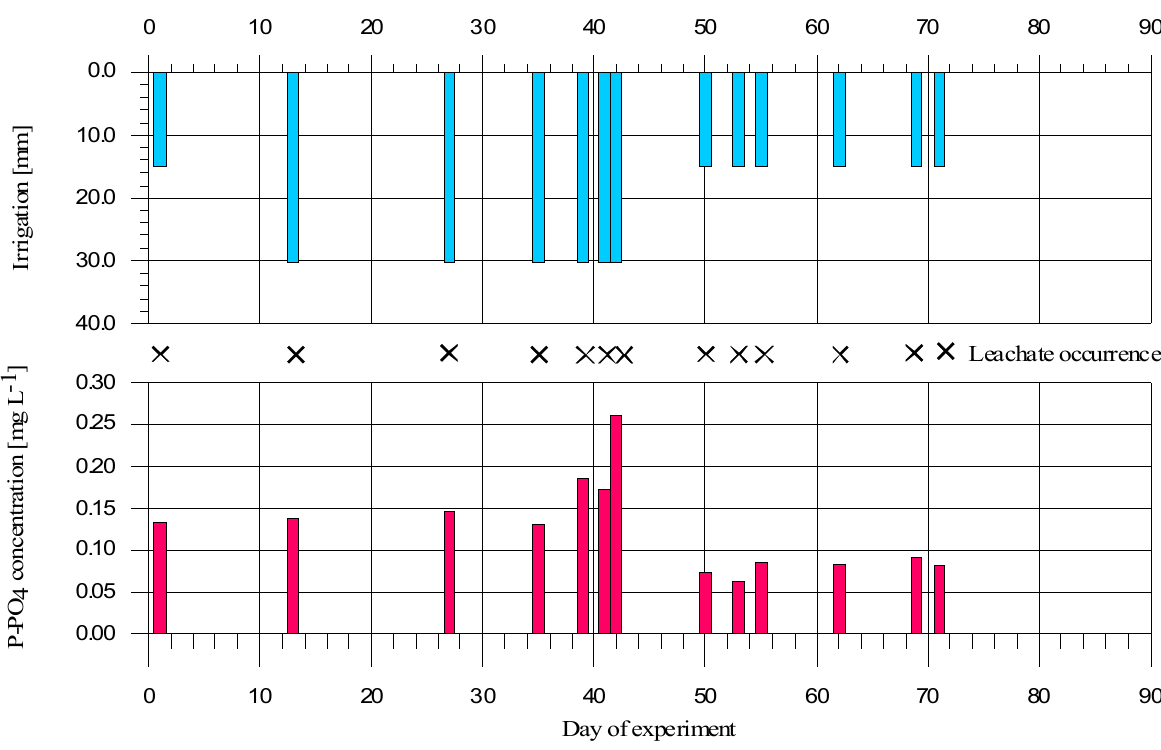
Figure 5. Irrigation rate, leachate occurrence and P-PO the substrate of extensive green roof substrate—reference level for column experiment, based on [8].